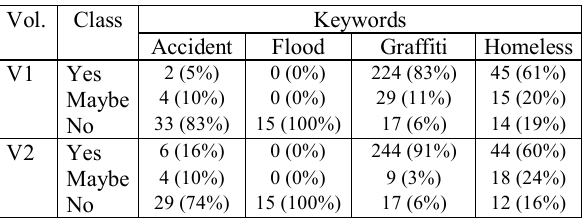
Table 3. Number and percentage of photographs classified as